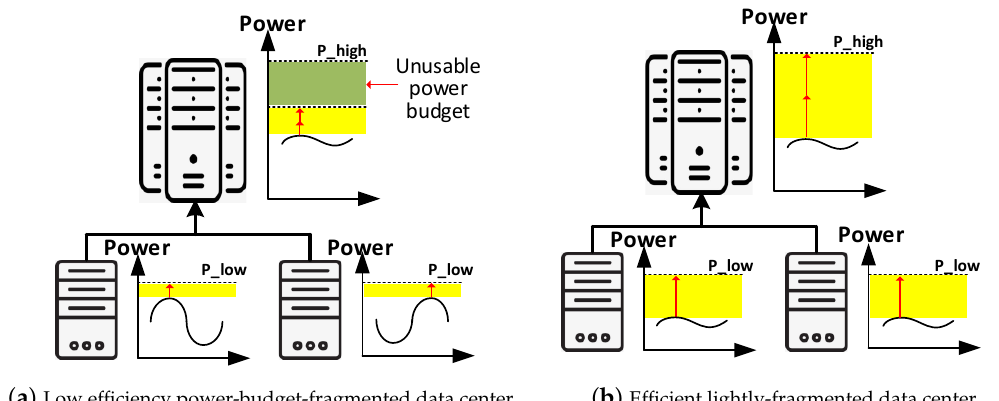
Figure 1. Power budget